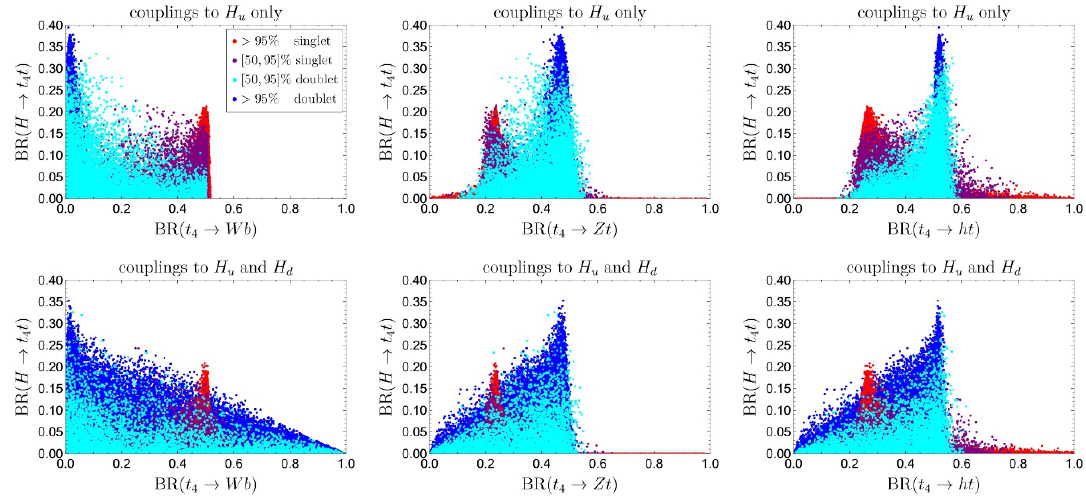
Figure 5 . Correlations between the branching ratio of H ! t 4 t and branching ratios of t 4 assuming couplings to H u only (top) and couplings to H u and H d (bottom). Di(cid:11)erent colors correspond to di(cid:11)erent singlet/doublet fractions of t 4 .